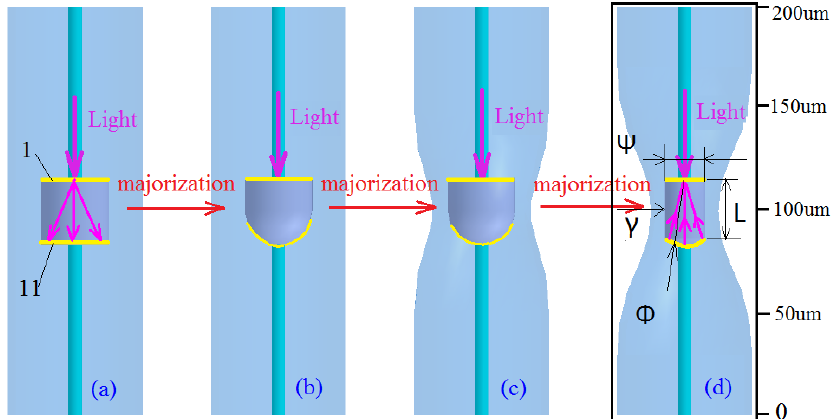
Figure 1. Majorization design of optical microcavity strain sensor. (SMF: the diameter of core is 8.2 µ m, the diameter of cladding is 125 µ m; Reflective surface I; Reflective surface II; Light: ) ( a ) F-P cavity with rectangular reflector; ( b ) F-P cavity with concave mirror; ( c ), ( d ) Hourglass in-fiber air Fabry-Perot Microcavity.